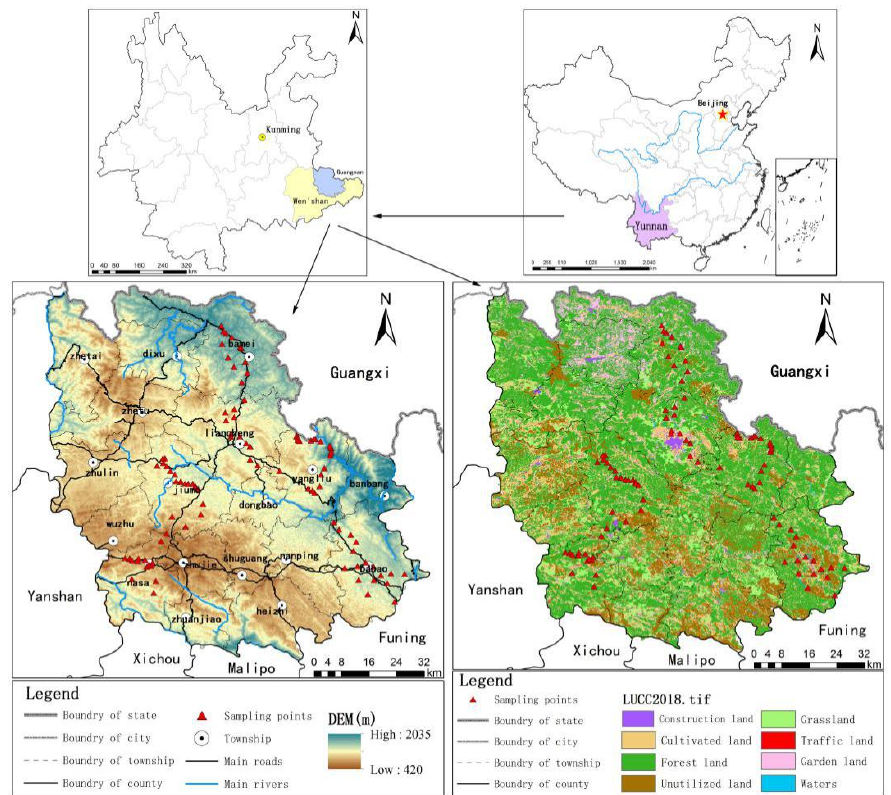
Figure 1. The geographical location of the study area.